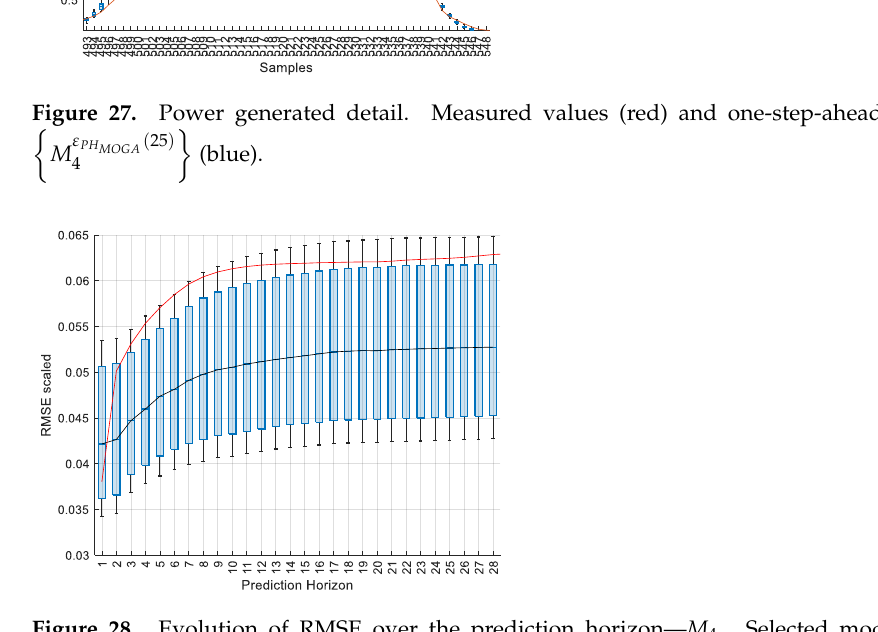
Figure 28. Evolution of RMSE over the prediction horizon — M 4 . Selected model (red) and (cid:26) (cid:27) ε PHMOGA ( 25 ) M (blue). 4